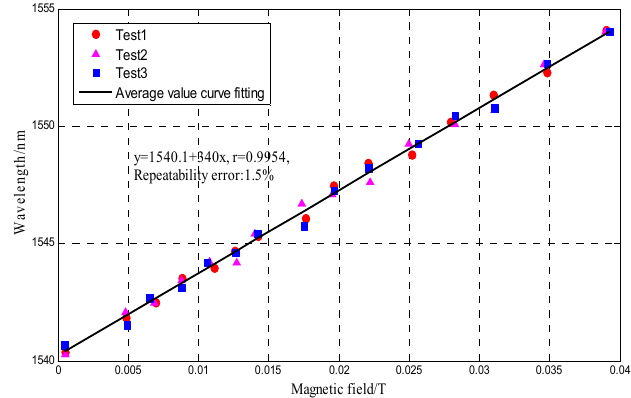
Figure 8. FP peak wavelength shift variation versus temperature.